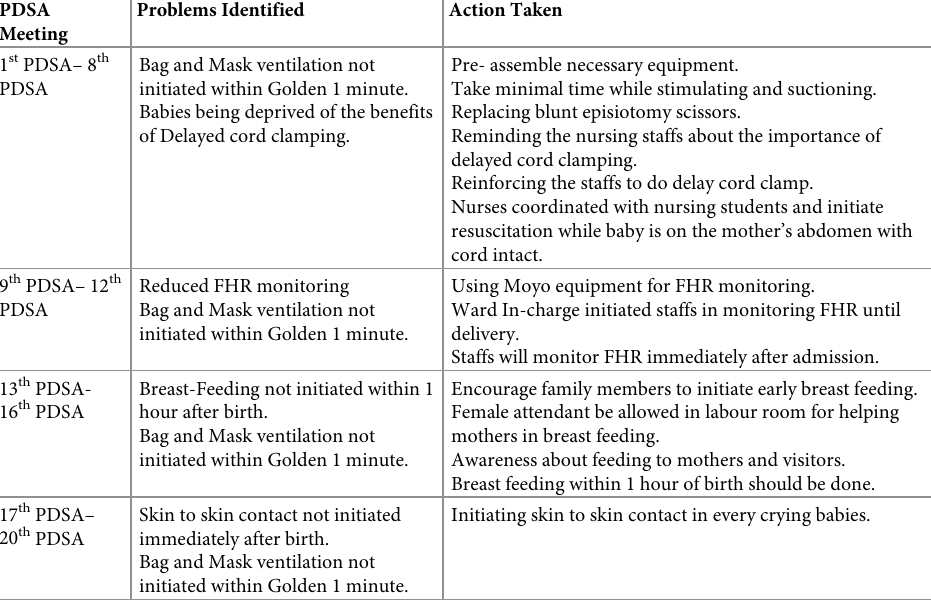
Table 2. Brief discussion note during each PDSA